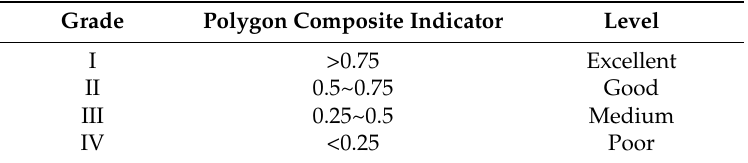
Table 7. The criteria for identifying the level of urban comprehensive carrying capacity. Grade Polygon Composite